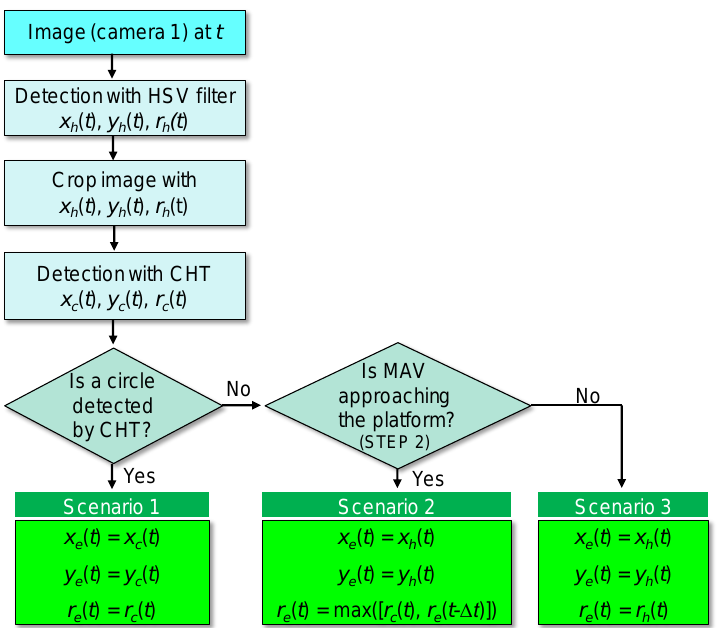
Figure 6. Flowchart of the new hybrid detection algorithm; x h ( t ) , y h ( t ) , and r h ( t ) denote the position along the x -axis, the position along the y -axis, and radius in the image calculated by the HSV filter at time t , respectively. x c ( t ) , y c ( t ) , and r c ( t ) are the position along the x -axis, the position along the y -axis, and radius in the image calculated by CHT at time t , respectively. x e ( t ) , y e ( t ) , and r e ( t ) are the final values of x , y , and r estimated by the new algorithm at time t , respectively. r e ( t − ∆ t ) is the radius estimated in the previous time.